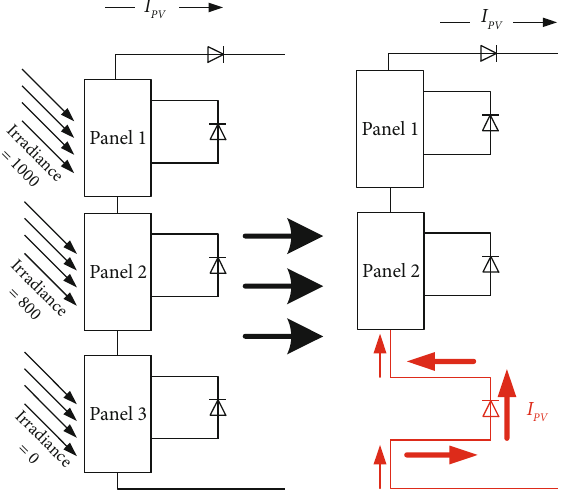
Table 2: Varied radiances of panels.